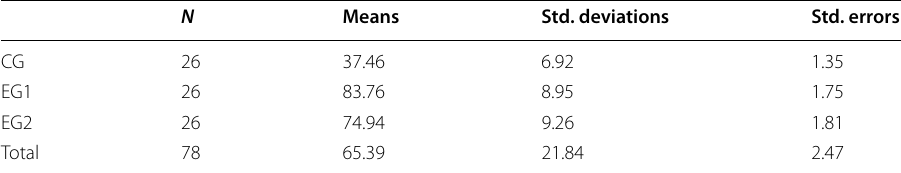
Table 12 Descriptive statistics: the participants’ post-test of FLLM N Means Std. deviations